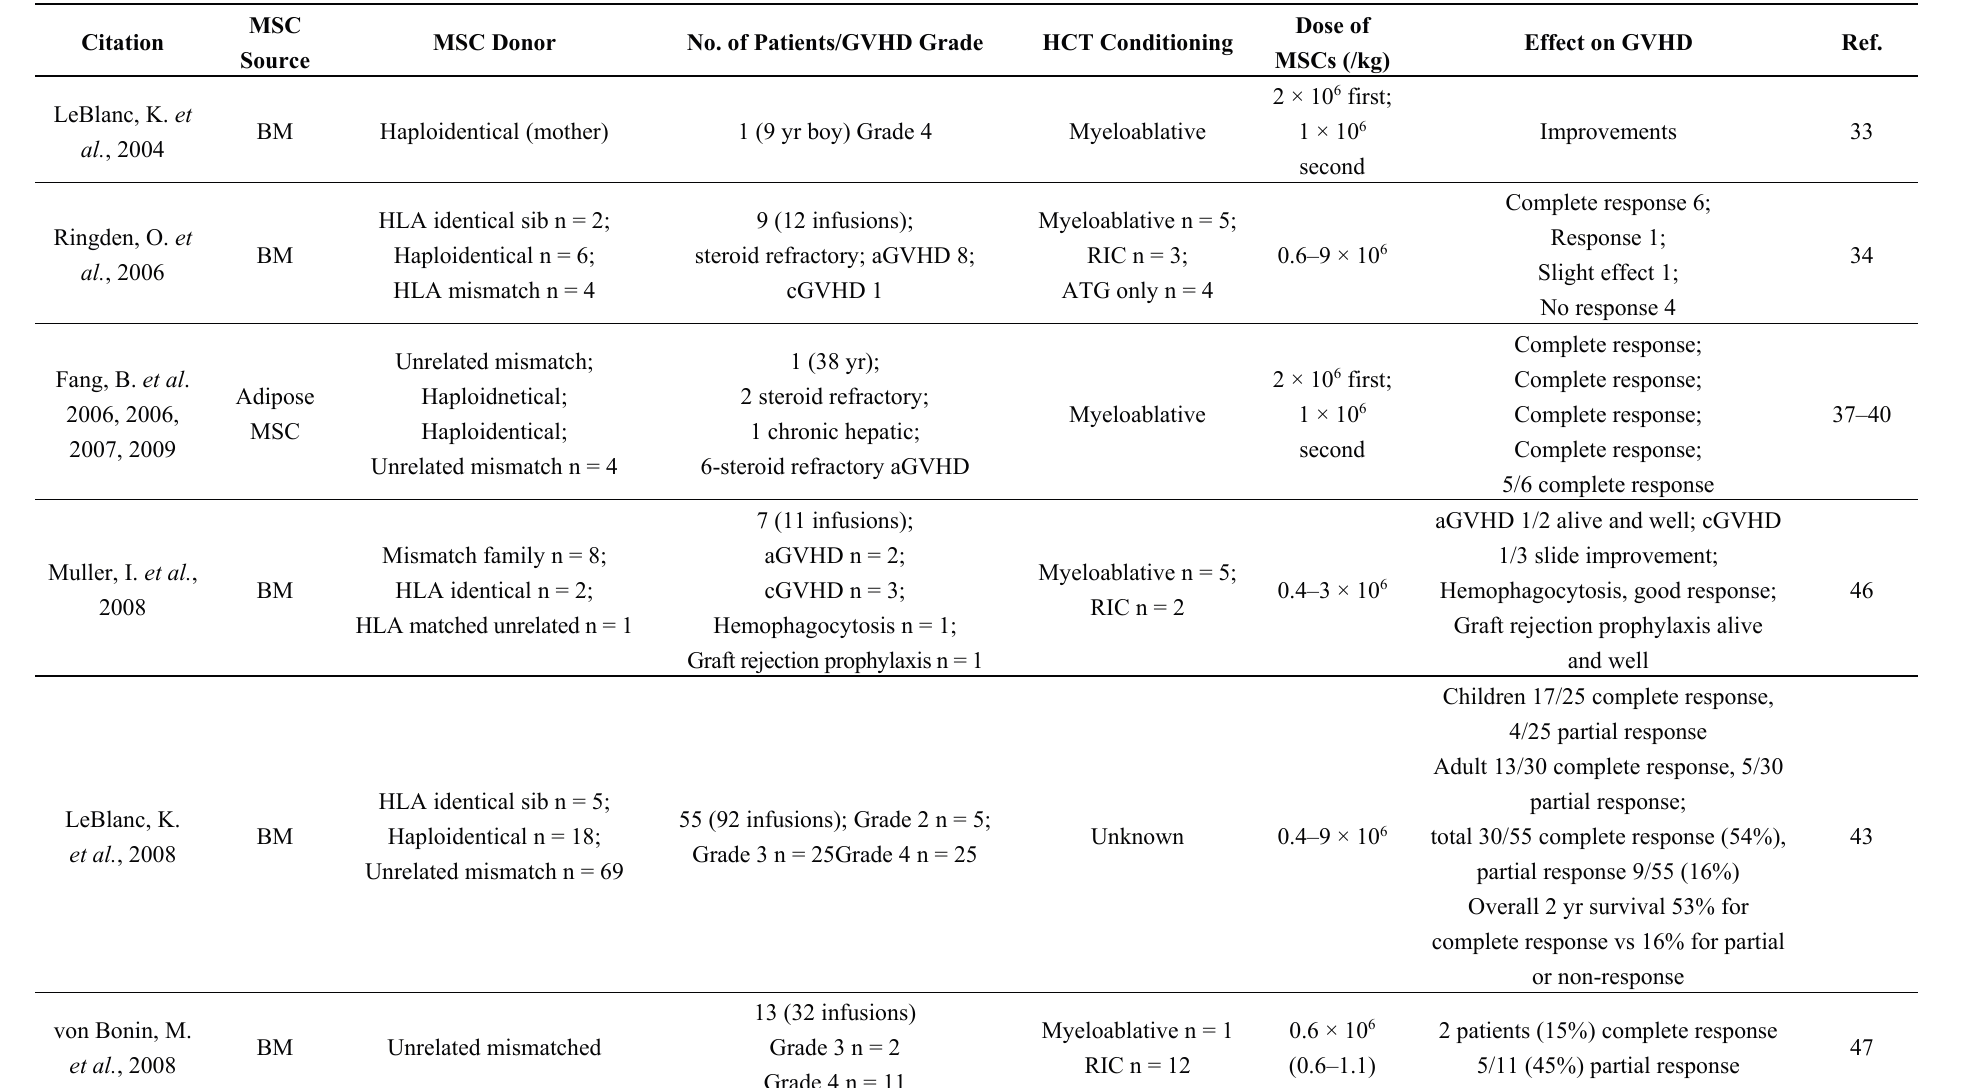
Table 1. GVHD patients treated with